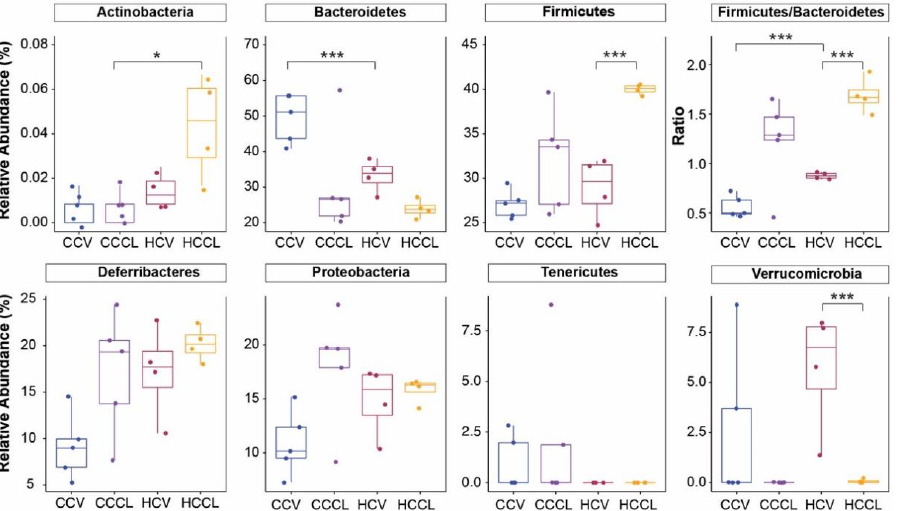
Figure 3. Phylum-level differences across treatments. CCV = offspring of control diet-fed dams treated with vehicle (n = 5); CCCL = offspring of control diet-fed dams treated with CL316,243 (n = 5); HCV = offspring of high-fat diet-fed dams treated with vehicle (n = 4); HCCL = offspring of high-fat diet-fed dams treated with CL316,243 (n = 4). Nonparametric multiple comparisons (* p < 0.05, *** p < 0.001).